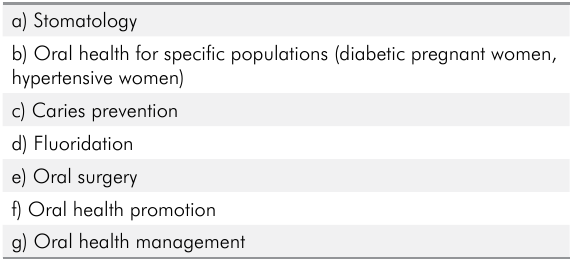
Table 2. Description of main topics of the teleconsultations requested.